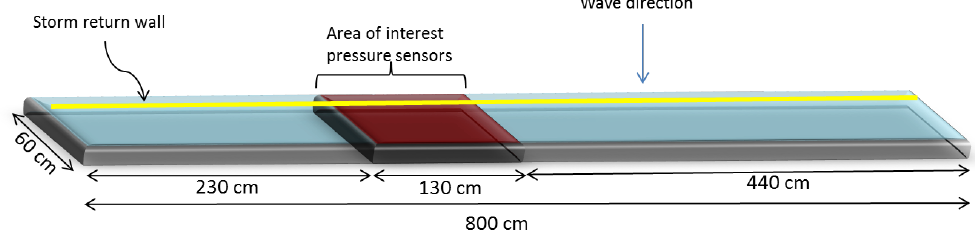
Figure 5. The structure used to investigate the force reduction (posterior view) (not to scale).